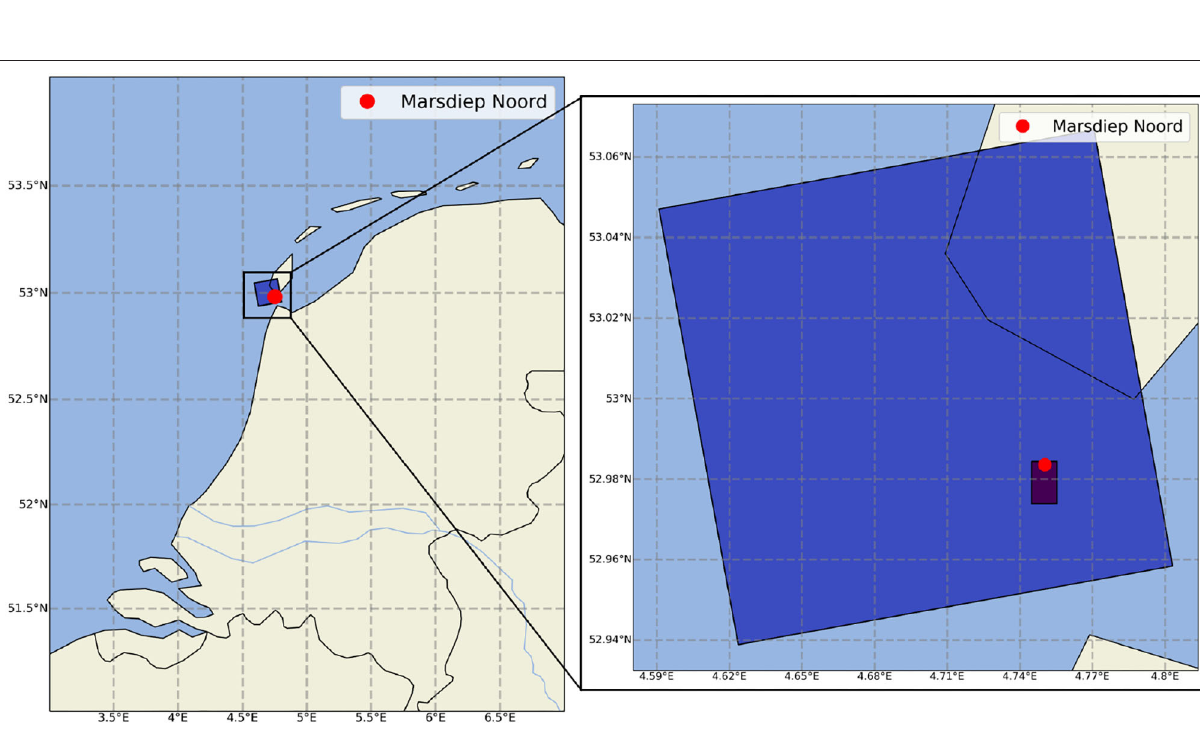
Frontiers in Marine Science |